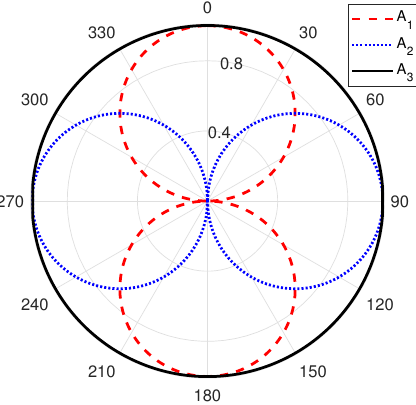
Figure 1. Ideal antenna pattern of the monopole-cross-loop antenna, which consists of two orthogonal loops (cosine loop, A 1 , and sine loop, A 2 ) and a monopole, A 3